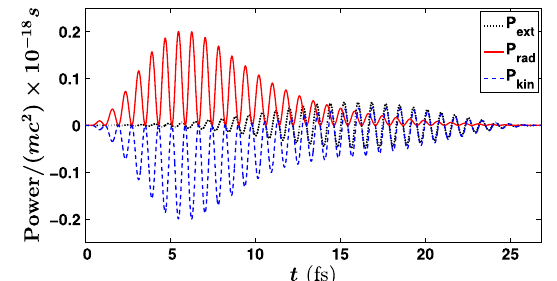
¼ 100 , and a pulse- 0 FIG. 7. P , P , and P plotted vs time t for a sinusoidal- ext rad kin envelope linearly polarized laser with parameters given in Fig. 4.